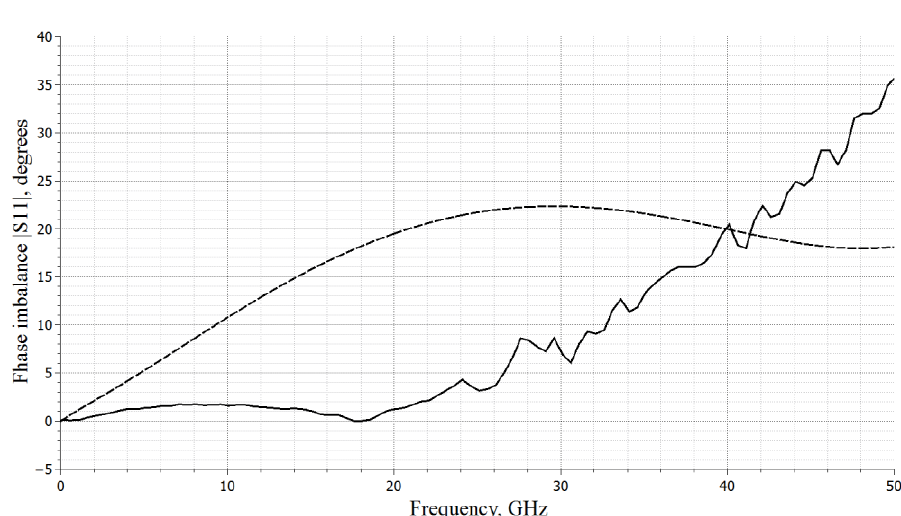
Fig. 10. Measured vs simulated phase imbalance for OPEN and SHORT